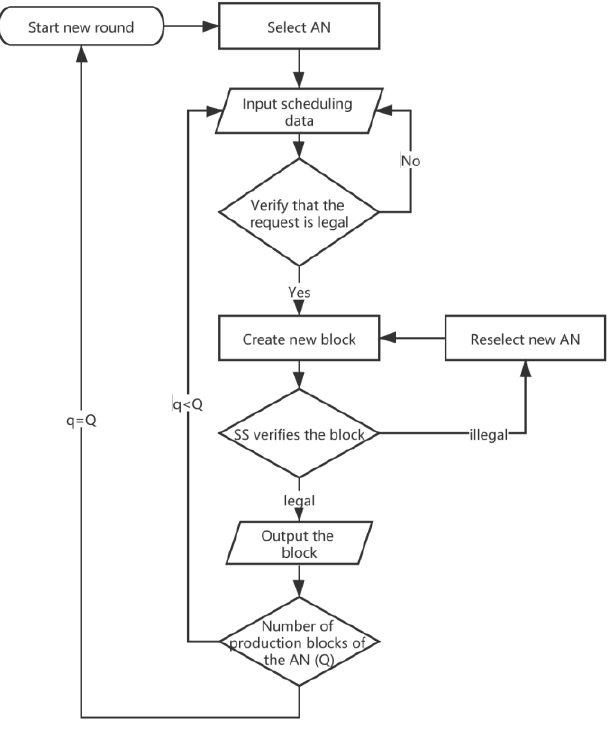
Figure 8. Algorithm 2 Flowchart. Sensors 2020 , 20 , x FOR PEER REVIEW